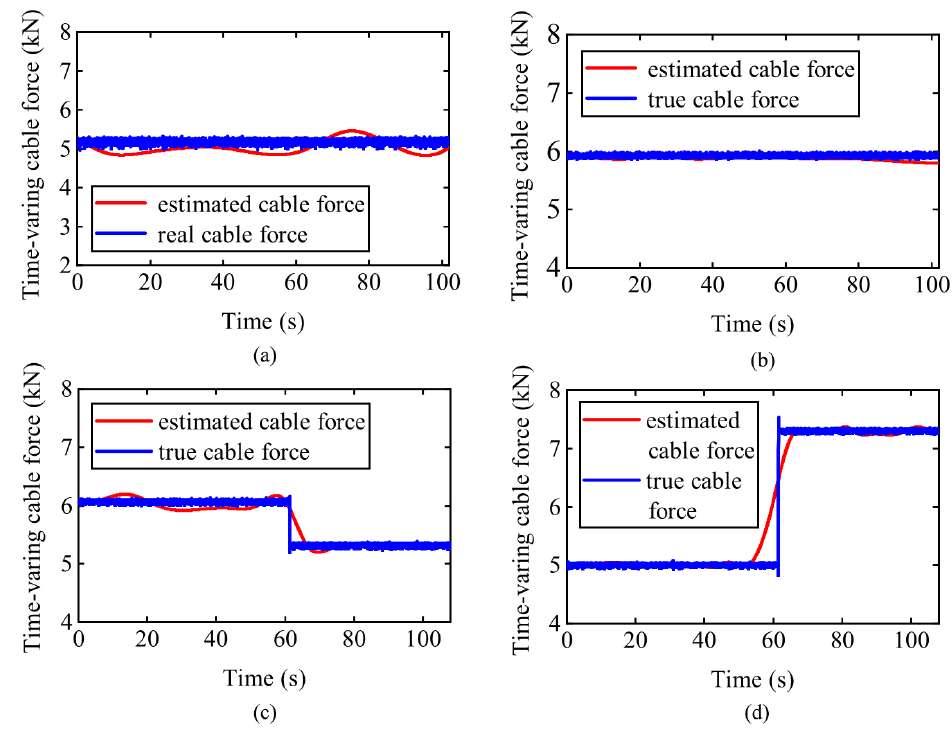
Figure 6. Time-varying cable forces of scale model experiment: ( a ) Condition 1, ( b ) Condition 2, ( c ) Condition 3, ( d ) Condition 4.